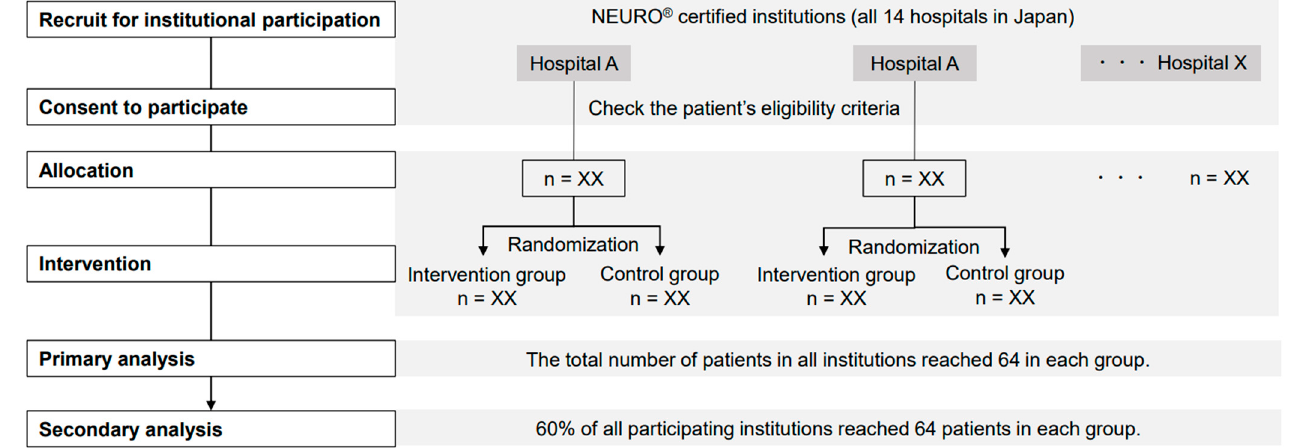
Figure 6. Research procedure. The study setting includes 14 NEURO ® -accredited facilities in Japan that have agreed to participate in the study. Once patients who meet the study eligibility criteria are enrolled, they will be assigned to the intervention and control groups using a random number table generated for each facility.